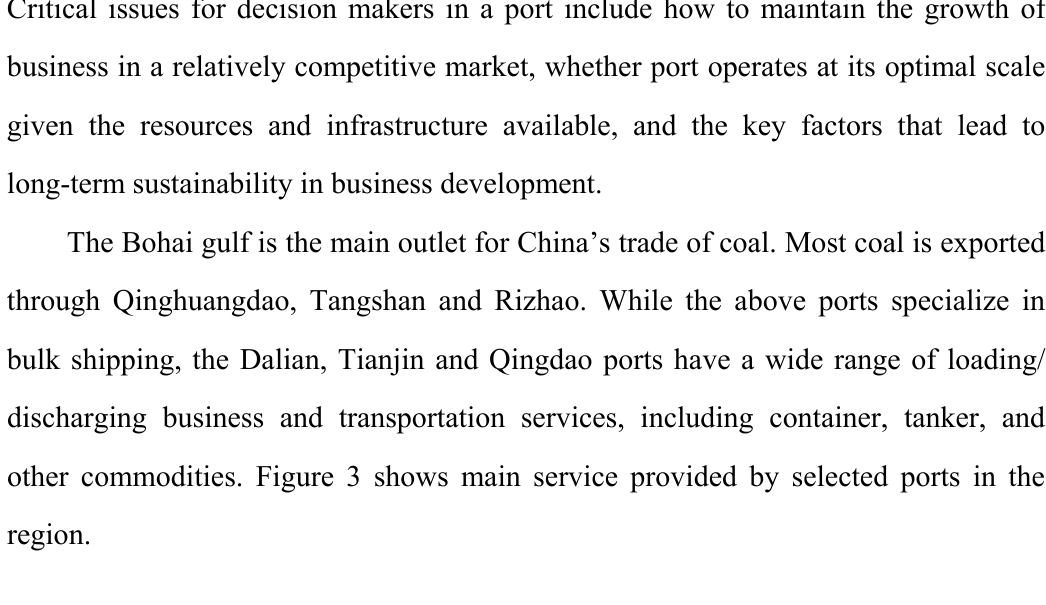
Figure 2. Throughputs of Bohai area over China ( in ten thousand tons)